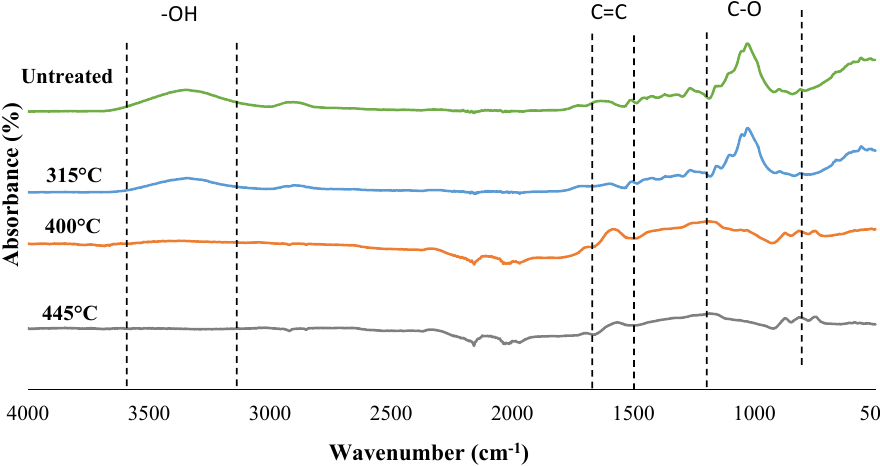
Figure 2. FTIR spectra of spruce wood and biochar treated at 315 °C, 400 °C and 445 °C.